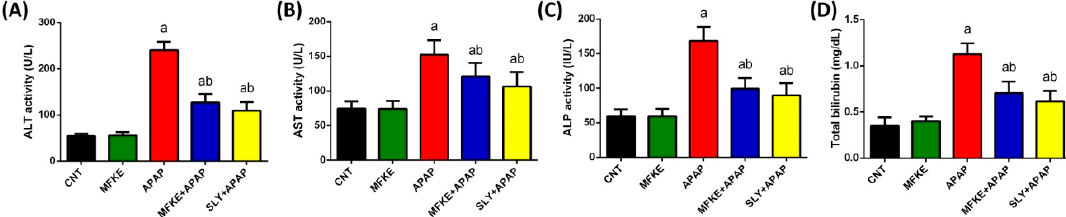
Figure 1. HPLC chromatogram of Myristica fragrans kernel extract at 280 nm. A mobile phase consisting of mixture of solvent A (0.2% acetic acid) and B (acetonitrile) and employing a gradient elution (from 10:90 to 100:0, v / v ) at a flow rate of 1 mL/min.